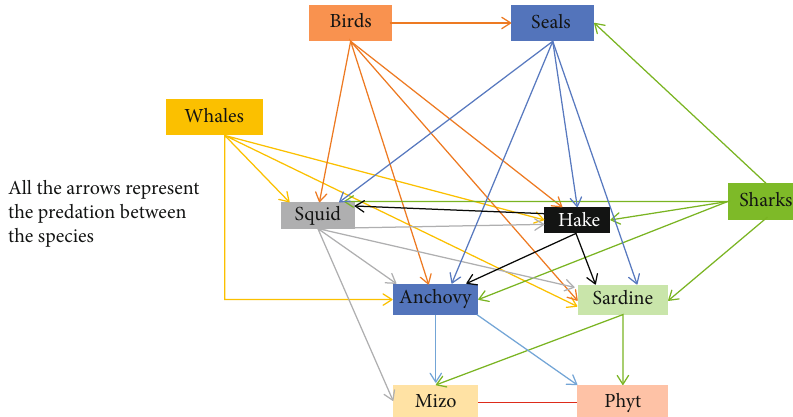
Figure 2: Interaction between ten